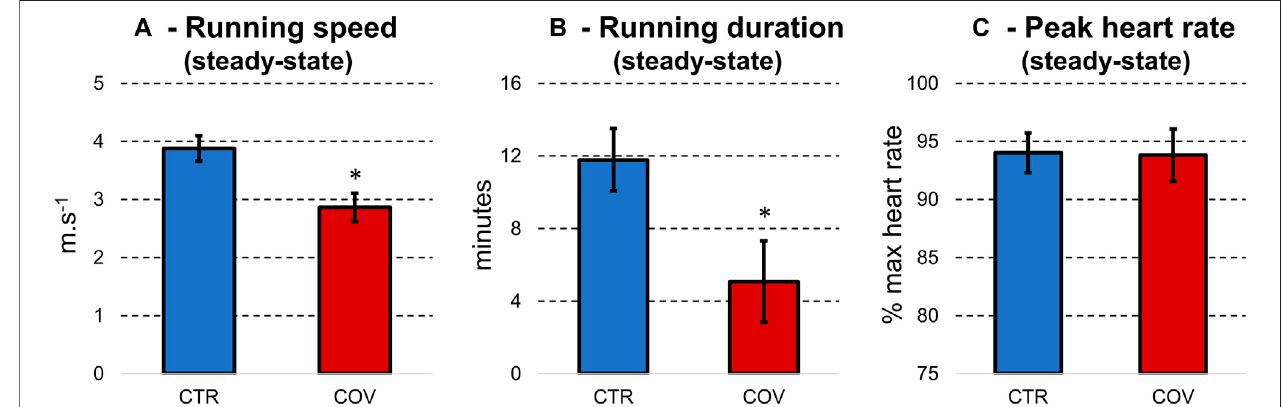
FIGURE 2 | Means and standard deviations for running speed (A) and duration (B) during the fatigue protocol and the steady-state running period. (C) illustrates the heart rate at the end of the steady-state running period. Data were extracted from the control group (CTR, blue bars) and hospitalized COVID-19 runners (COV, red bars). *denotes signi fi cant difference in relation to CTR ( p <